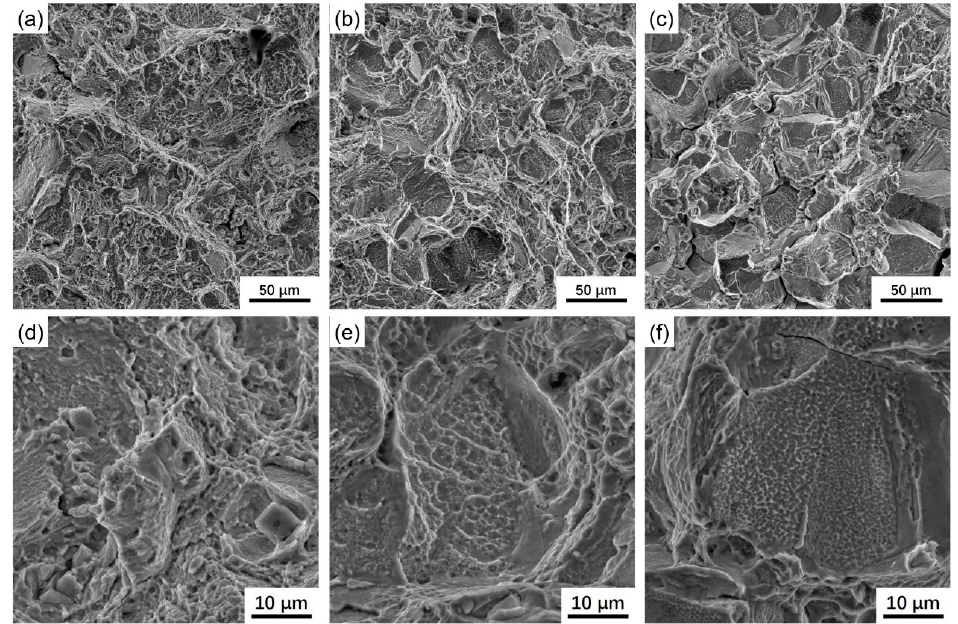
Figure 7. Micro morphology of the propagation area. ( a , d ) Furnace cooling; ( b , e ) Air cooling; ( c , f ) Oil quenching.